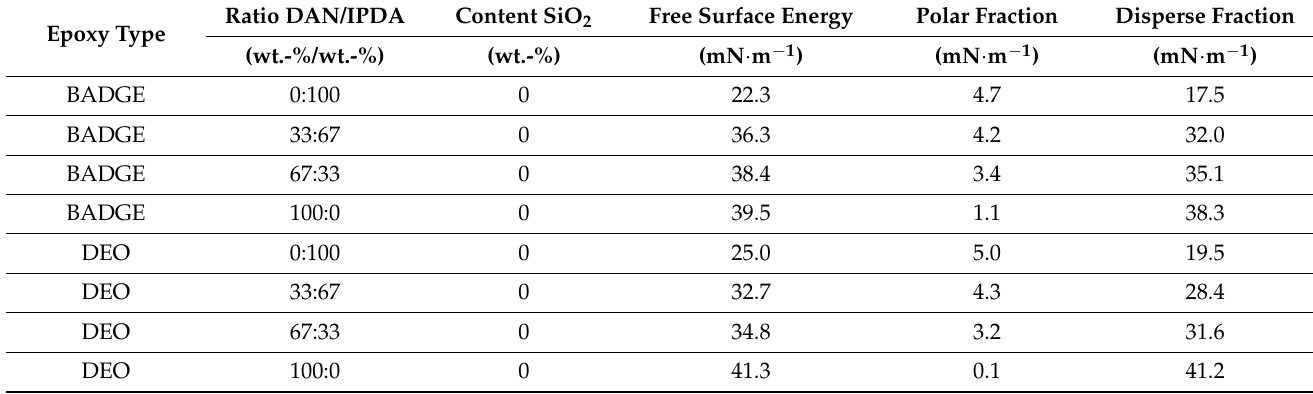
Table 2. Surface energy of the BADGE- and DEO-based epoxy-amine blends with varying contents of diamine-based